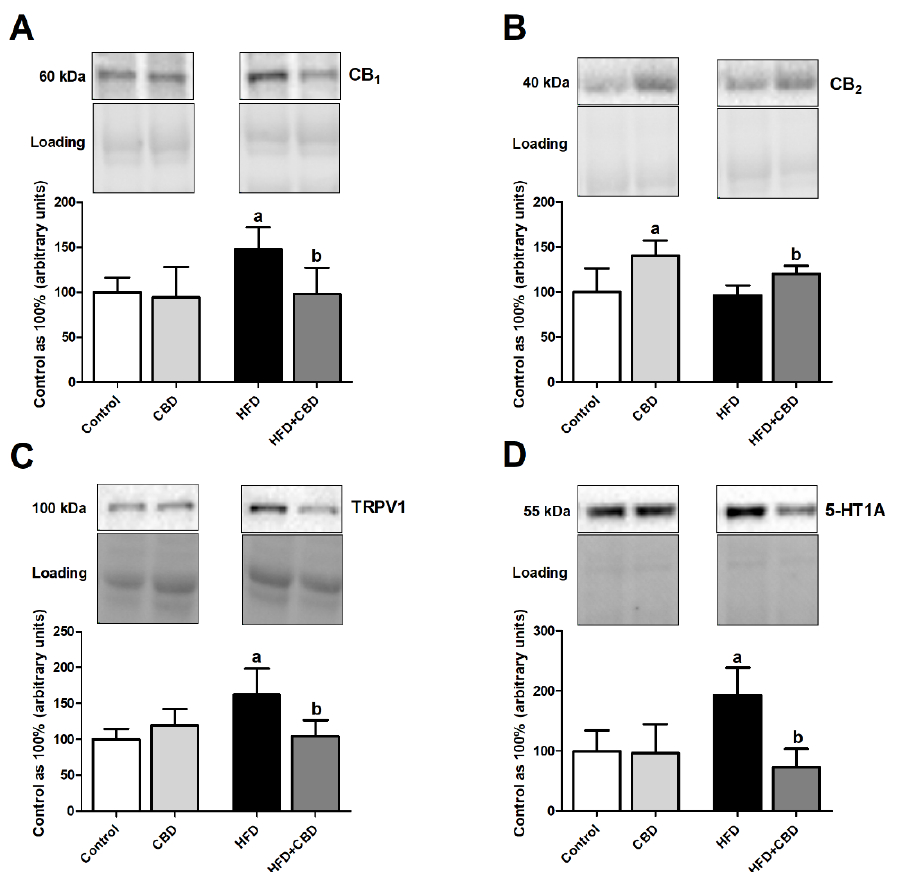
Figure 4. The total expression of ( A ) cannabinoid receptor 1 (CB 1 ), ( B ) cannabinoid receptor 2 (CB 2 ), ( C ) transient receptor potential channel 1 (TRPV1), and ( D ) serotonin receptor (5-HT1A) in red gastrocnemius muscle in the control (standard diet) and high-fat diet (HFD) groups after chronic cannabidiol (CBD) treatment. The total expressions of the above proteins are presented as a percentage di ff erence compared to the control group, which was set as 100%. The data are expressed as mean values ± SD, n = 6 in each group. a p < 0.05 significant di ff erence: control group vs. examined group; b p < 0.05 significant di ff erence: HFD vs. HFD + CBD.